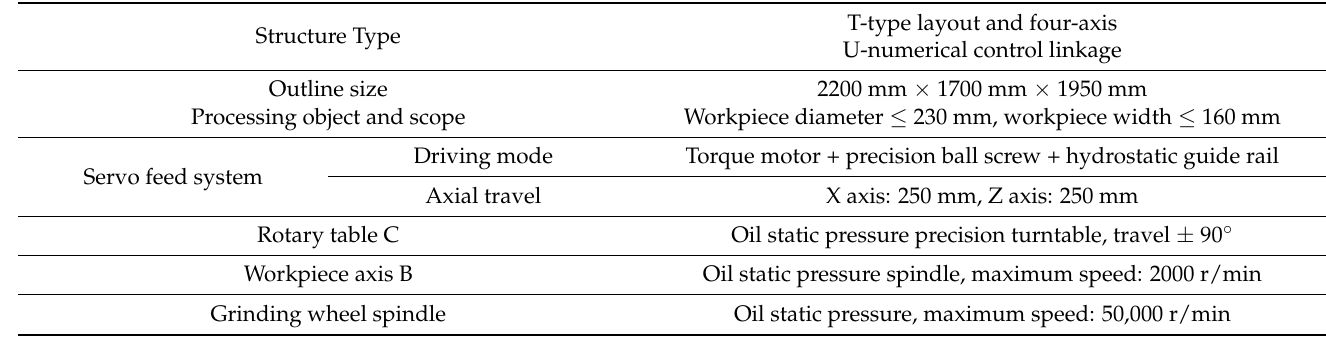
Table 5. Main specification parameters of